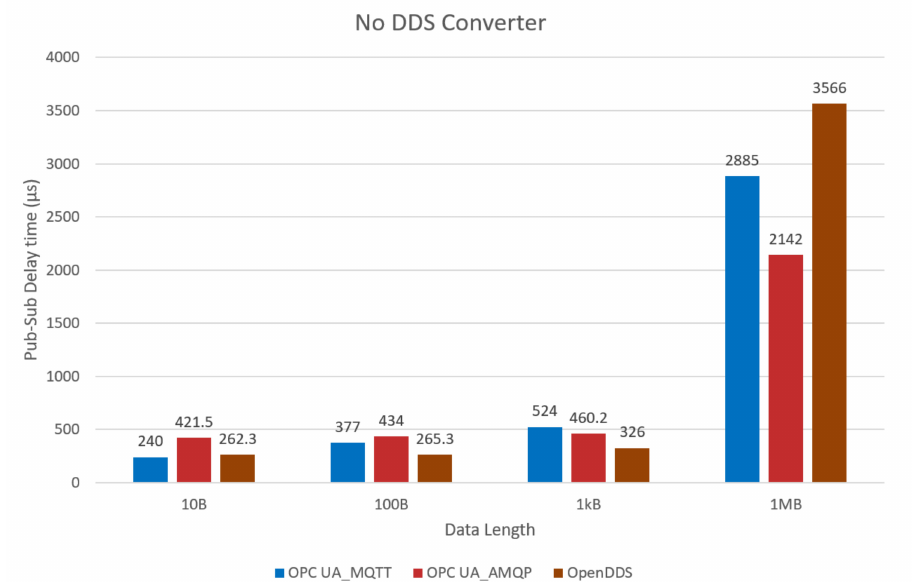
Figure 16. OPC UA PubSub and OpenDDS latencies without converter.